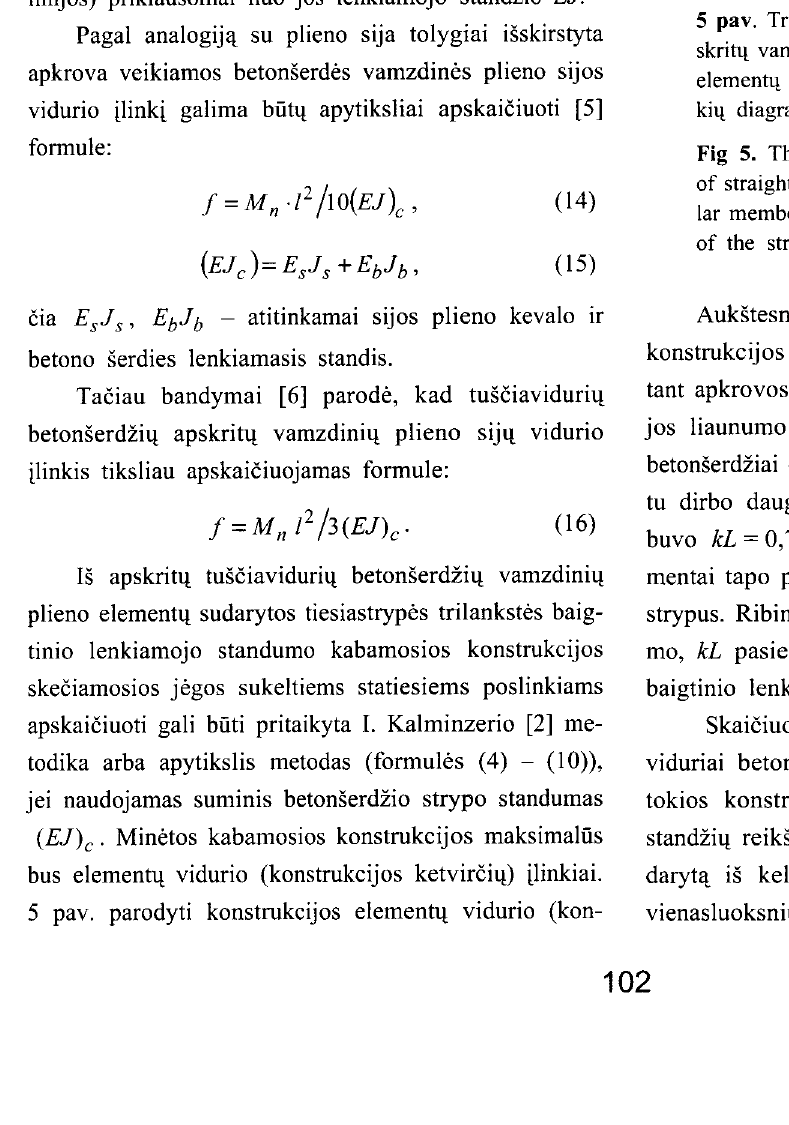
Fig 4. Distribution of displacements of straight-line three hinge suspension structure due to flexible stiffness EJ of cables